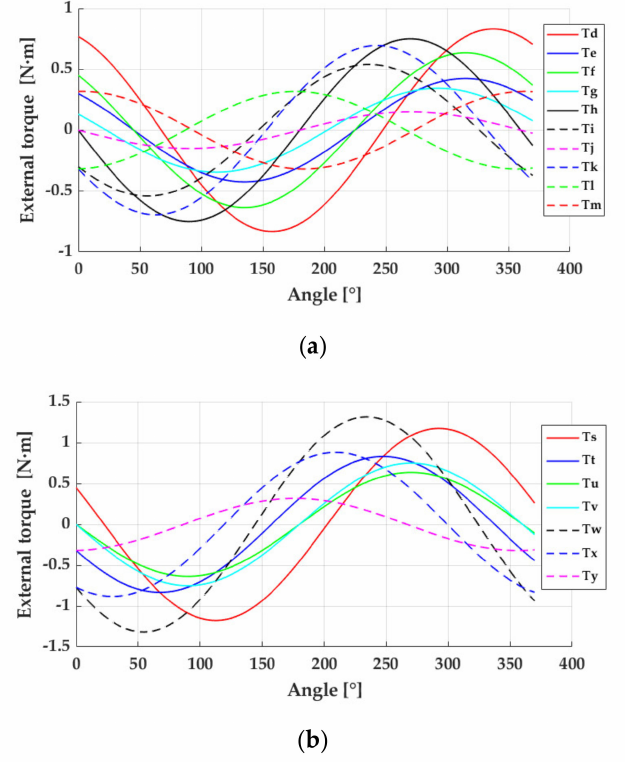
Figure 3. External variable torque: ( a ) produced by 2 pairs of masses, ( b ) produced by 4 pairs of